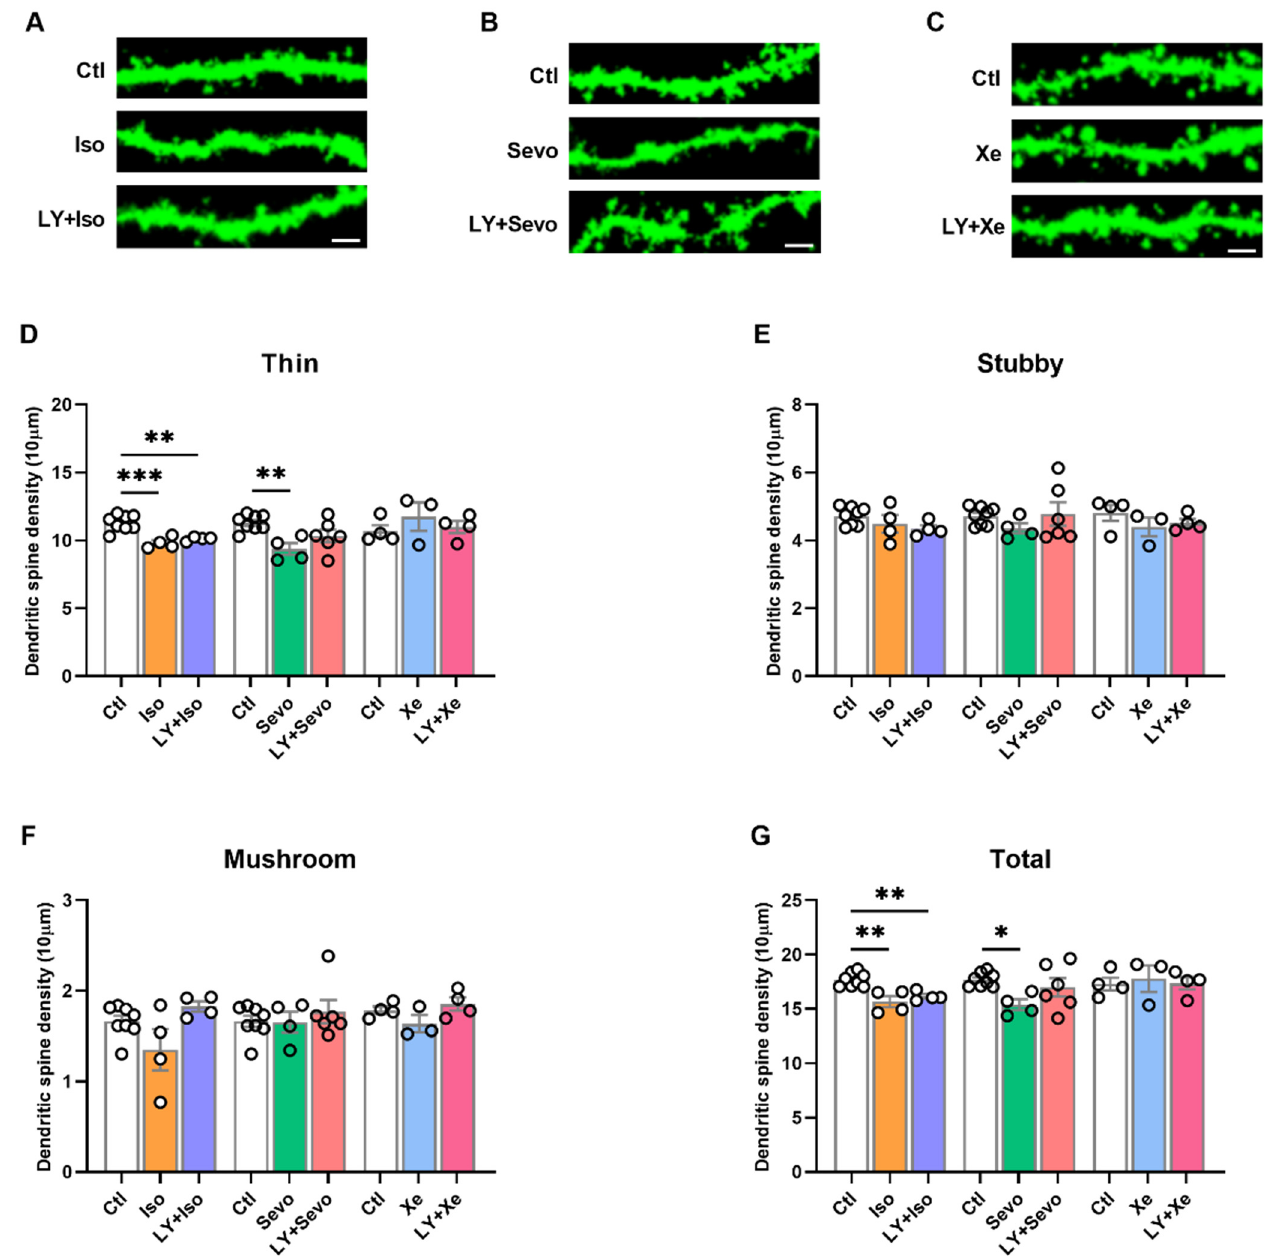
Figure 3. Xe did not change spine density, and BACE inhibition partly reversed the sevo-induced spine elimination, but not that induced by iso. ( A – C ) Representative apical dendritic segments of CA1 pyramidal neurons of all groups. Scale bars = 2 µm. ( D ) Thin spines were reduced under iso, sevo, but not Xe application (ctl vs. iso: p = 0.0006; ctl vs. sevo: p = 0.0066). ( E , F ) No change of stubby or mushroom spines between groups. ( G ) Total spines were significantly reduced after iso and sevo, but not Xe application (ctl vs. iso: p = 0.0012; ctl vs. sevo: p = 0.0370). LY partly restored the negative effects of sevo, but not that of iso (ctl vs. LY + iso: p = 0.0095; ctl vs. LY + sevo: p = 0.6194). Spines did not alternate under Xe or LY + Xe conditions (D–G). One-way ANOVA followed by Tukey’s test. For each animal, six dendritic segments were analyzed. Data are shown as mean ± SEM. Dots represent the number of animals. Detailed statistics are provided in Table S1. * p < 0.05, ** p < 0.01, *** p < 0.001. Ctl: control, iso: isoflurane, LY: LY2886721, sevo: sevoflurane, Xe: Xenon. In the presence of sevo, thin and total spines were also reduced (Figure 3d, thin spines: ctl [11.30 ± 0.20], n = 8; sevo [9.37 ± 0.44], n = 4; p = 0.0066; Figure 3g, total spines: